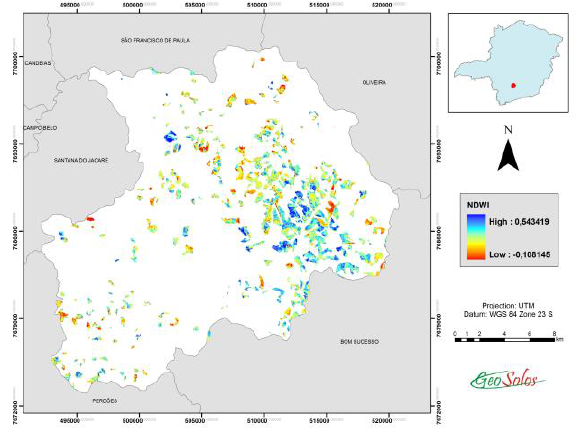
Figure 3. NDWI of coffee fields of Santo Antonio do Amparo, Minas Gerais, Brazil.